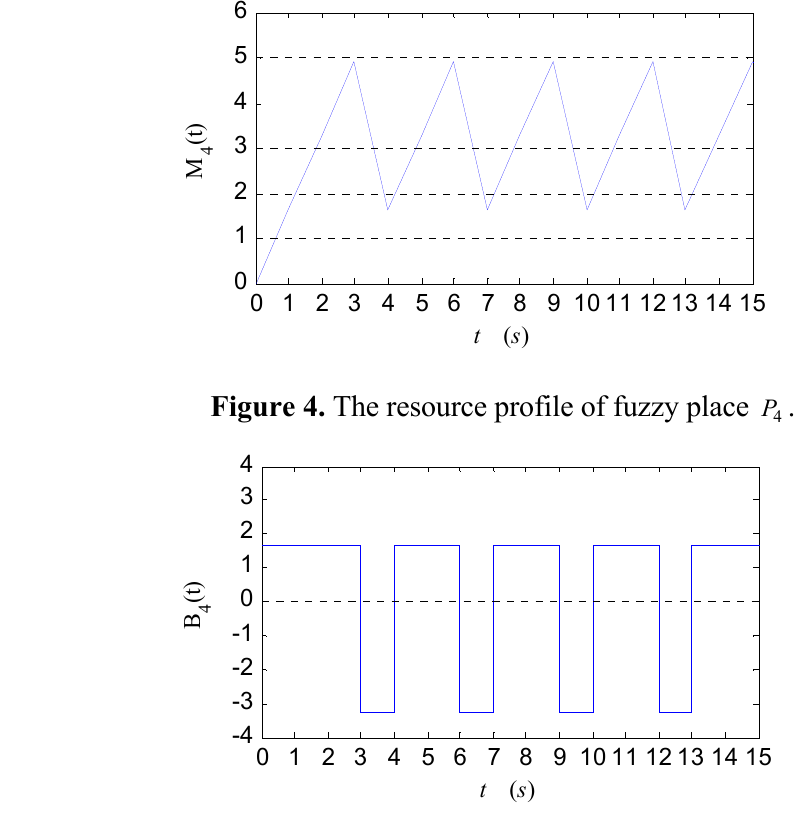
Figure 5. The dynamic balance